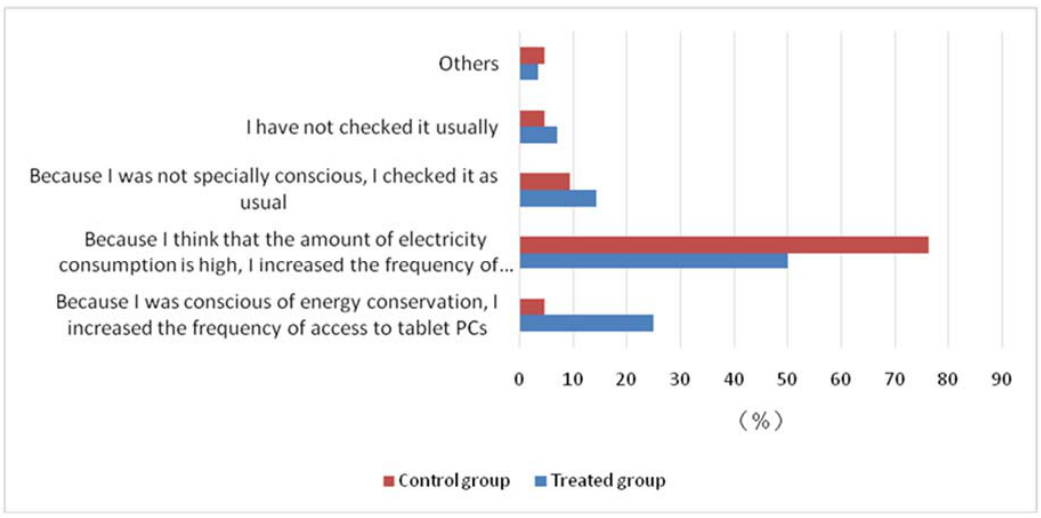
Figure 6. Frequency of access to tablet PCs between control and treated households.